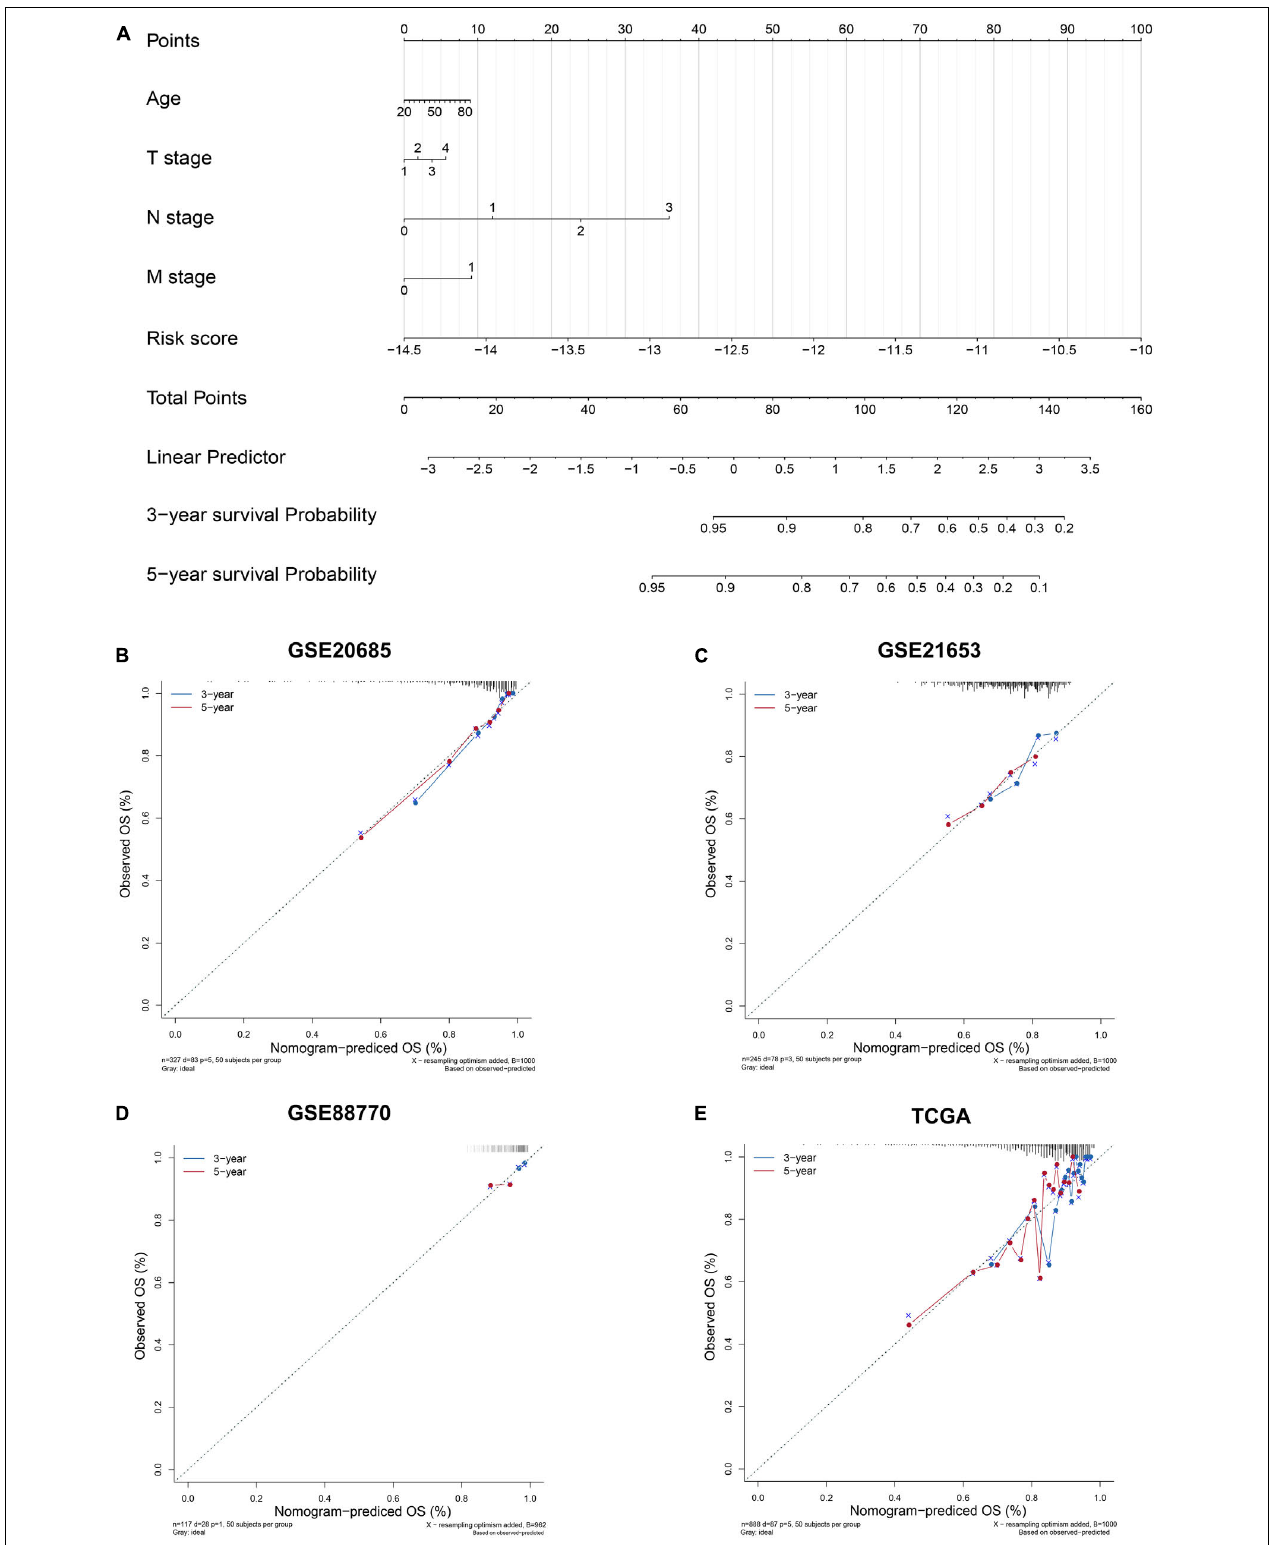
FIGURE 4 | Construction and Evaluation of Nomogram. (A) Nomogram to predict survival probability. (B–E) Three- and 5-year nomogram calibration curves in training and validation sets. The training set: GSE20685. The validation sets: GSE21653, GSE88770, and TCGA.